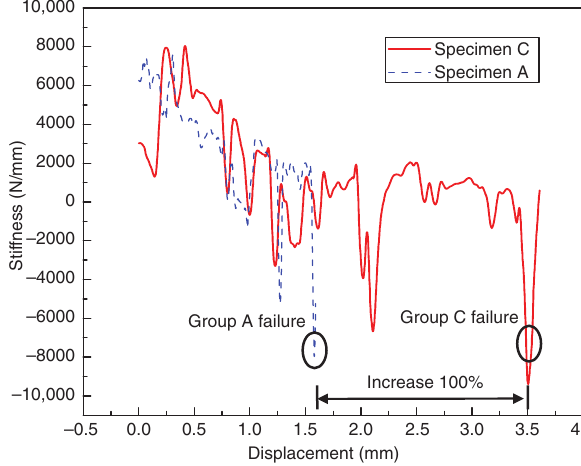
Figure 9: Stiffness spectrum comparison between specimen C and Specimen A.